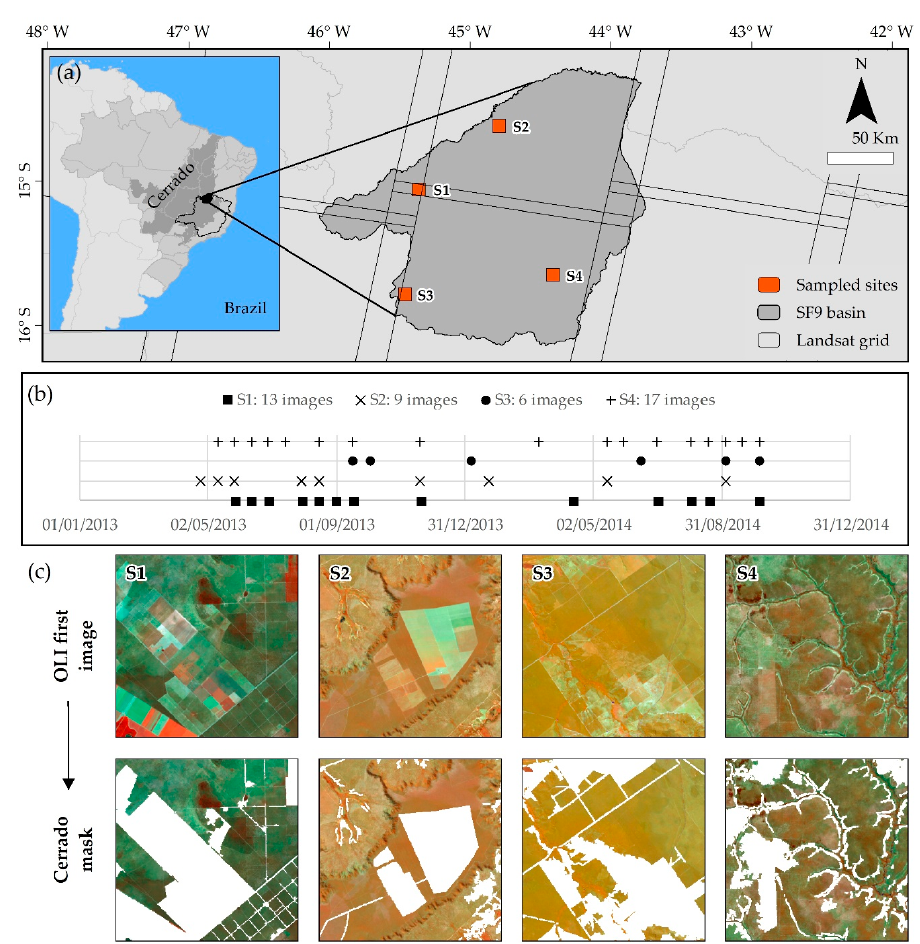
Figure 1. ( a ) The study area in the north of Minas Gerais (MG) state, Brazil, and the details of the sampling design; ( b ) cloud-free image acquisition dates per sampled site; ( c ) sampled areas represented by Landsat OLI image false color composition (Red = NIR, Green = SWIR 1, Blue = Red) and Cerrado mask layer from land cover classification.